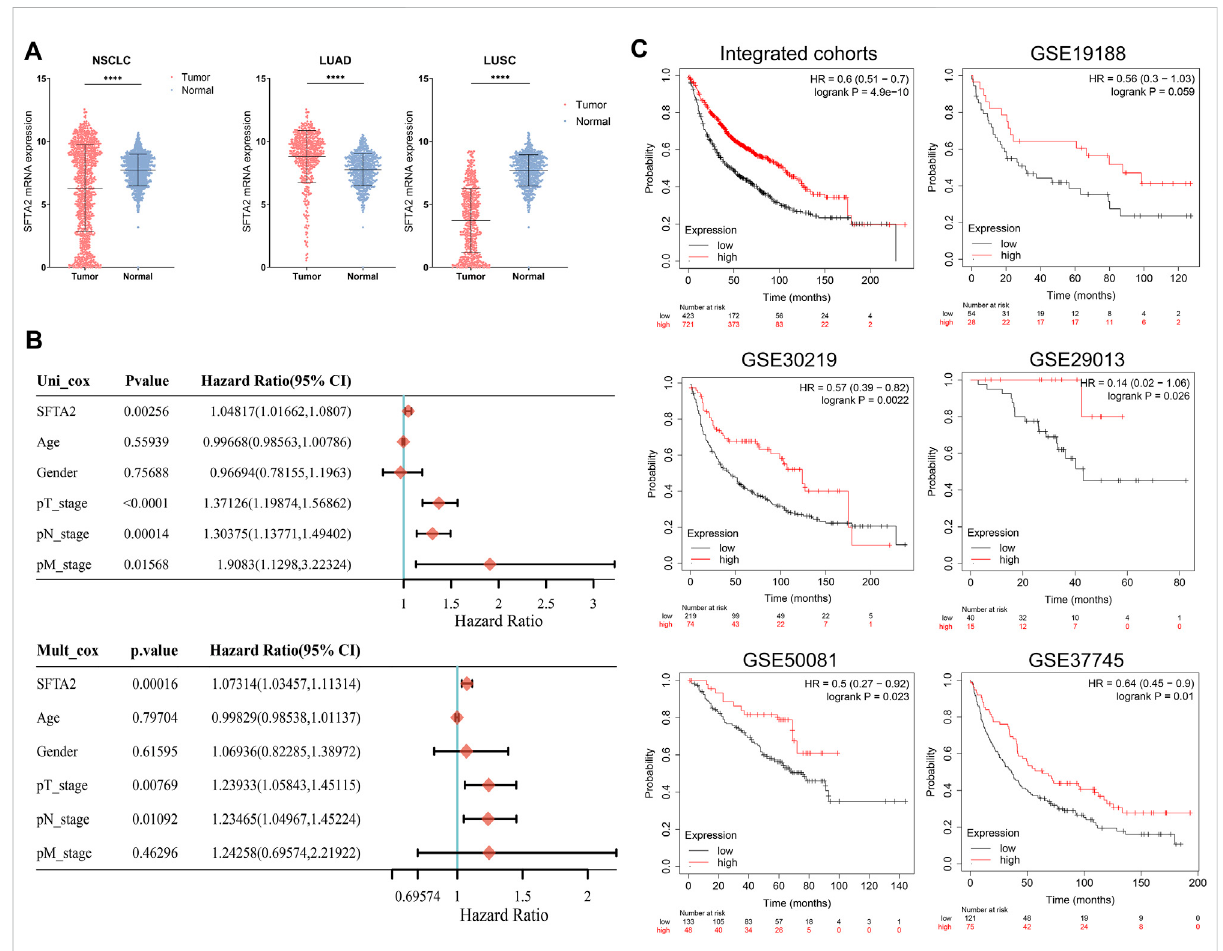
FIGURE 5 Potential implications of SFTA2 expression in outcomes of NSCLC. (A) We compared the expression of SFTA2 in normal and tumor tissues in NSCLC andsubgroups ofLUAD and LUSC. (B) Weperformed univariate andmultivariateregression analyses to fi nd thefactors related to thesurvival of NSCLC patients. (C) We utilized independent cohort samples to study the relationship between SFTA2 expression and survival